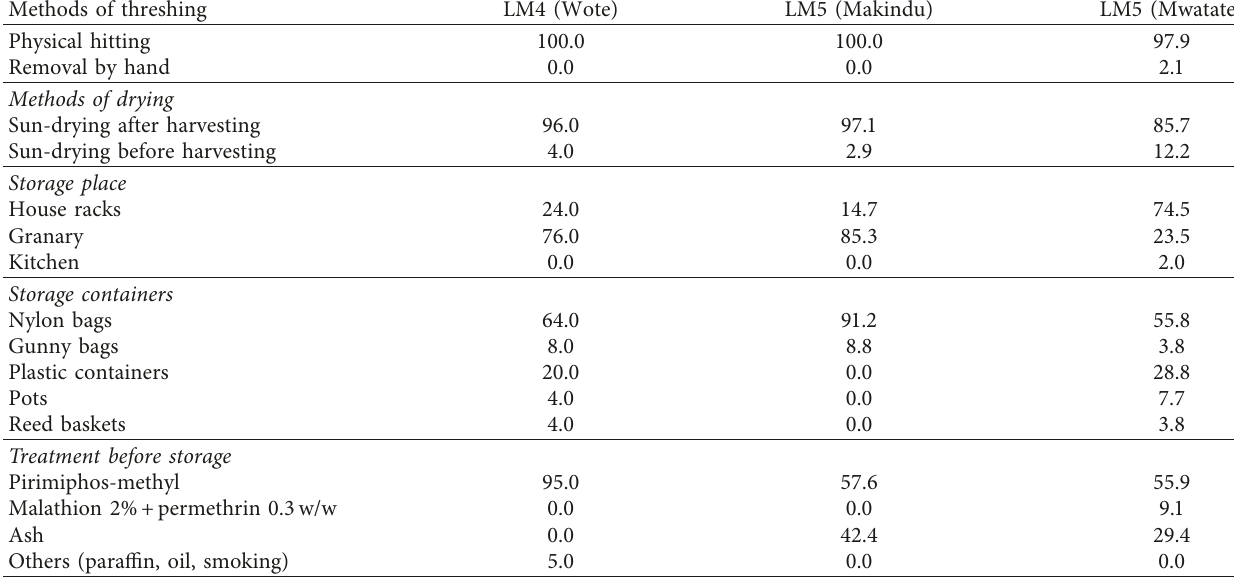
Table 3: Percentage of farmers using various postharvest handling practices of cowpea seeds in various agroecological zones in Makueni and Taita Taveta during the 2016 long rains.